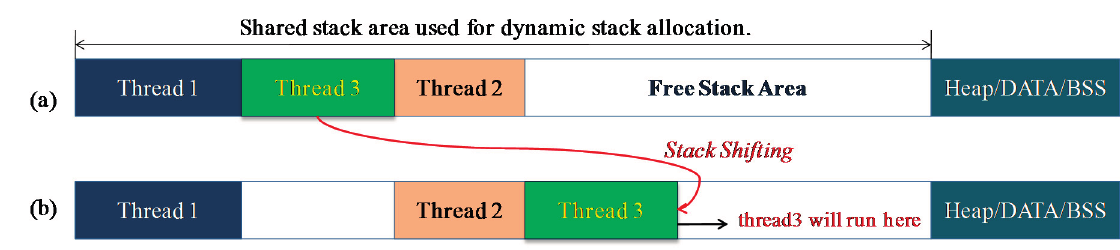
Figure 6. If thread3 needs to be executed, its stack should be shifted so that it will not corrupt the context data of thread2 during the run-time.